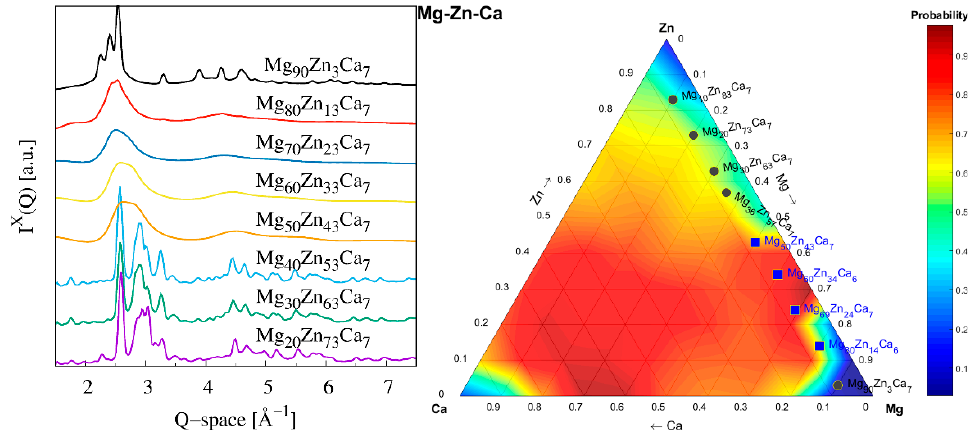
Figure 1. ( left ) The X-ray diffraction patterns of the as-prepared Mg 93 − x Zn x Ca 7 specimens indicated by legend (intensity curves are vertically offset for clarity reasons) and ( right ) the Mg-Zn-Ca ternary colourmap showing a prediction of the glass forming probability calculated by a machine learning algorithm. The alloys prepared in this work identified as crystalline are marked by circles and those identified as amorphous are labelled by squares.